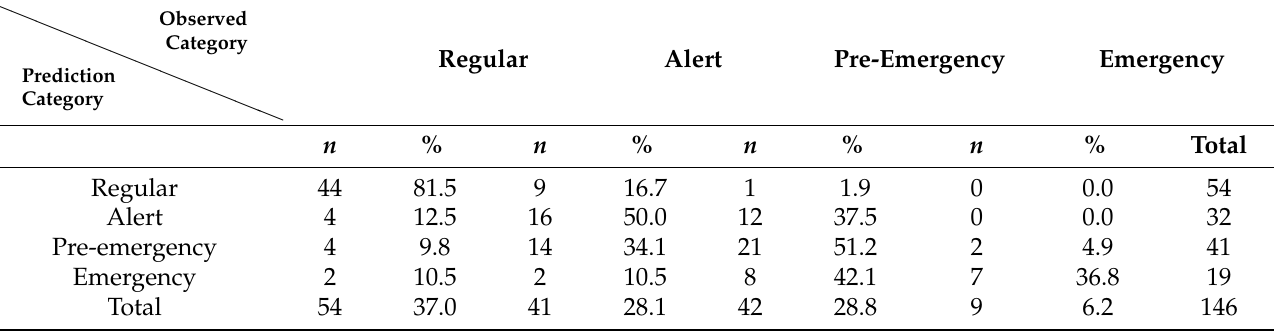
Figure 7. Predicted versus observed PM2.5 levels ( a ) and residual histogram ( b ) for the BS- t model with Chilean PM data. Table 8. Categorization of observed and predicted PM2.5 levels according to air quality regulations during the CEM period for the Pudahuel monitoring station in Santiago, Chile, during 2015.